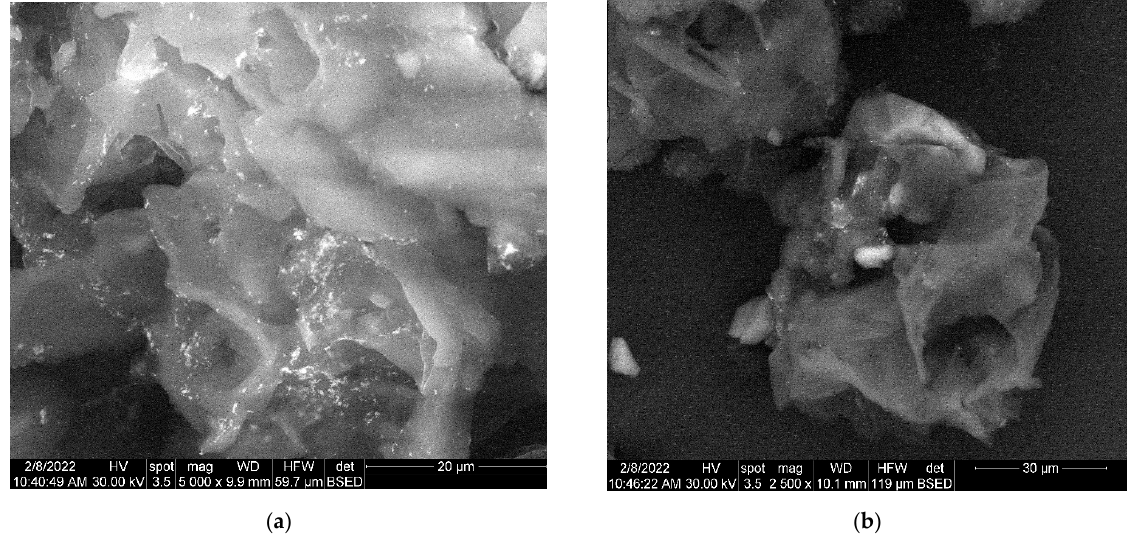
Figure 6. ( a ) Two-dimensional image of the viscum sample obtained by the SEM technique (magnitude 200 µm). ( b ) Two-dimensional image of the viscum sample obtained by the SEM technique (magnitude 50 µm).